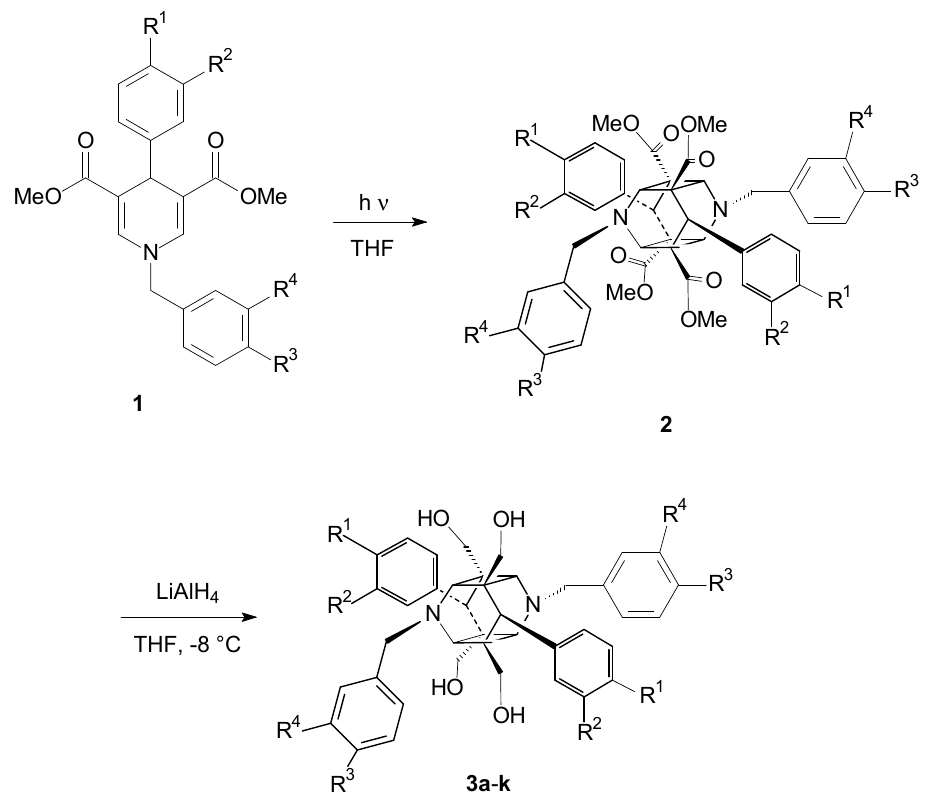
Scheme 1. Cage dimer target formation via 1,4-dihydropyridines.